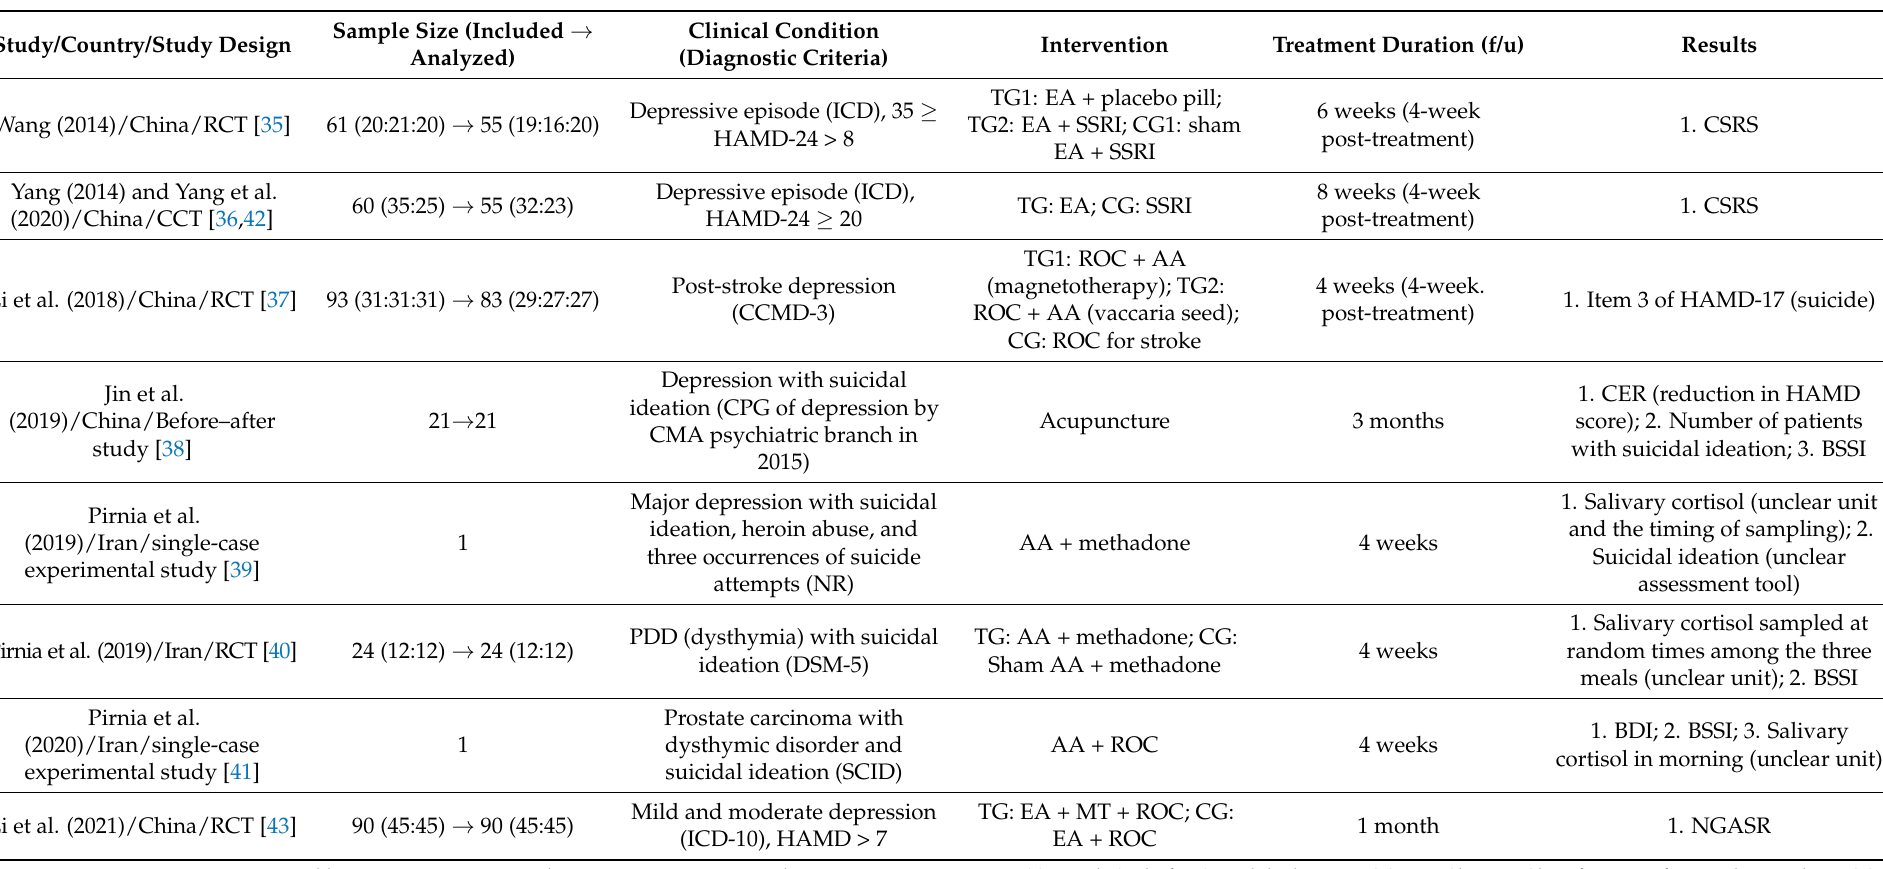
Table 1. Characteristics of the included